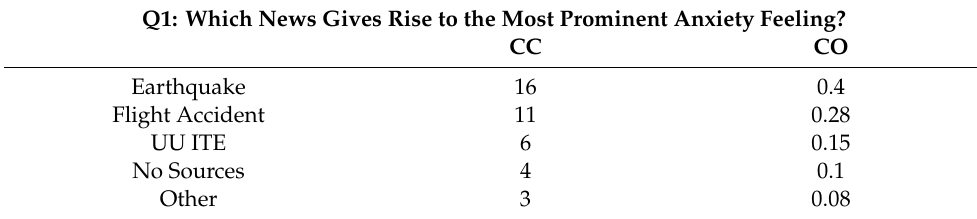
Table 14. Co-occurrences of Question 1.